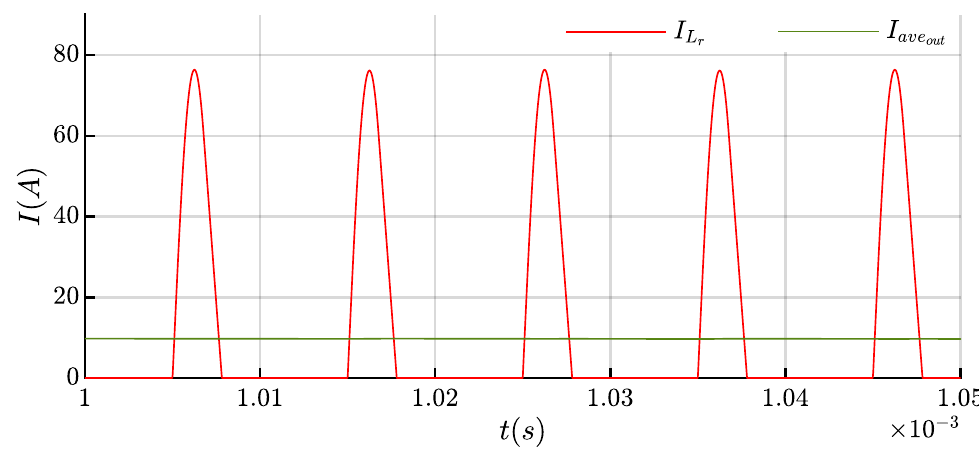
Figure 13. Inductor peak current and average output current.